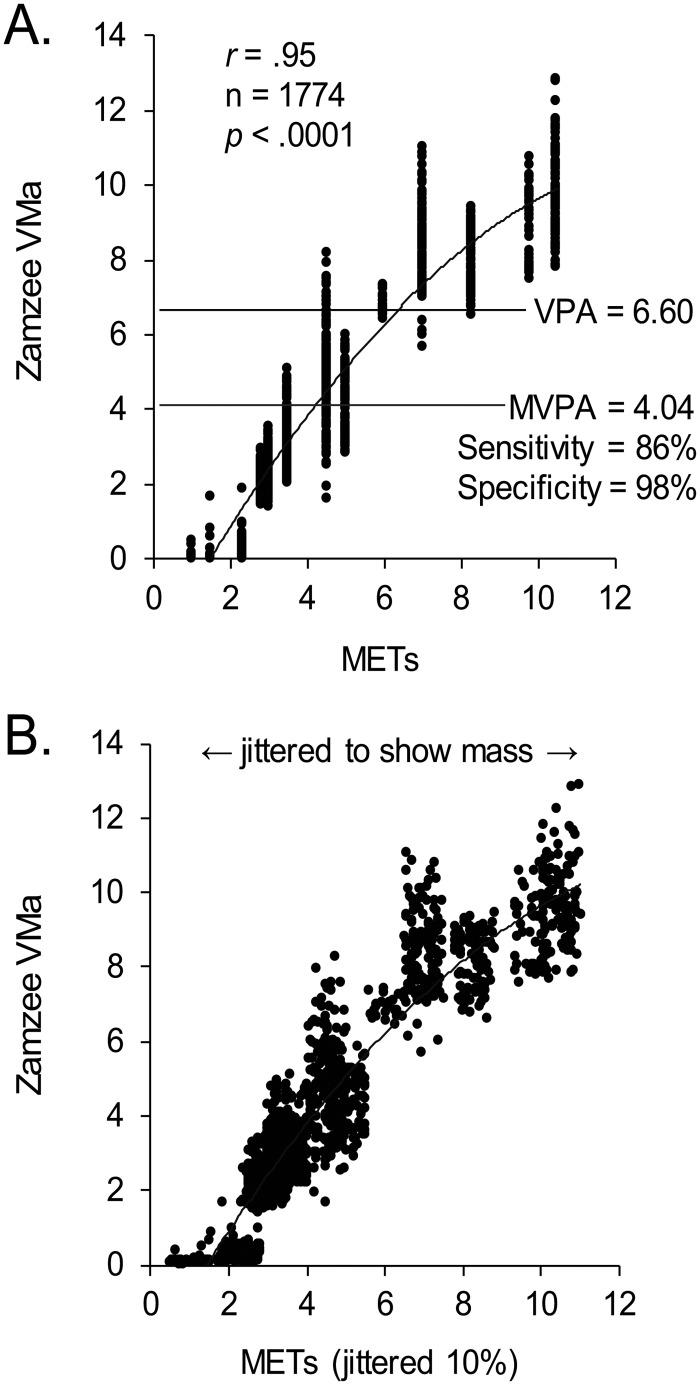
Correspondence between Zamzee VMa values and experimentally manipulated activity intensity (in METs).(A) Receiver operating characteristic analyses were applied to the parametric physical activity calibration data (described in Fig 1) to identify optimal accelerometer VMa cut points for distinguishing moderate-to-vigorous physical activity (MVPA = activity ≥ 4 MET intensity) and vigorous physical activity (VPA = activity ≥ 6 MET intensity). r and p values derive from ancillary Spearman rank correlation analyses to assess monotonic relationship between VMa and METs over the entire range of activity intensities examined.